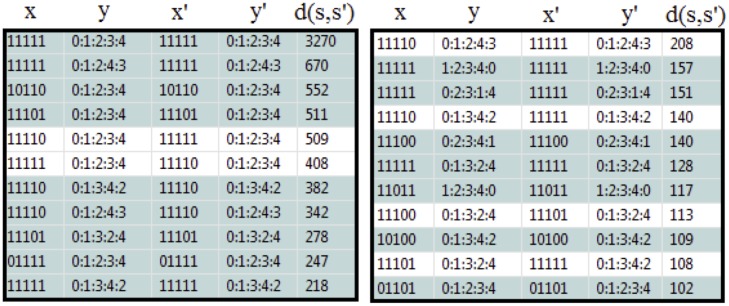
Densities d(s, s′) ≥ 100 from state s = (x, y) to s′ = (x′, y′) in SA Rich households.Highlighted lines are self-transition, i.e. s = s′.